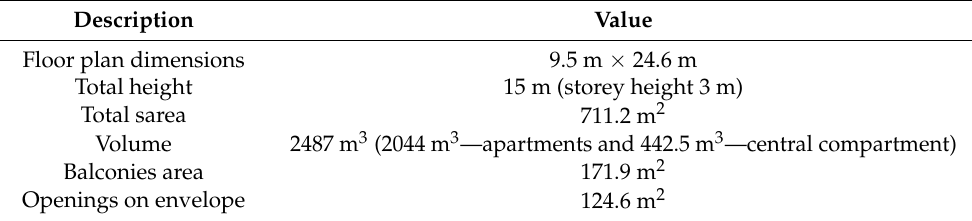
Table 3. Main characteristics of the Reference